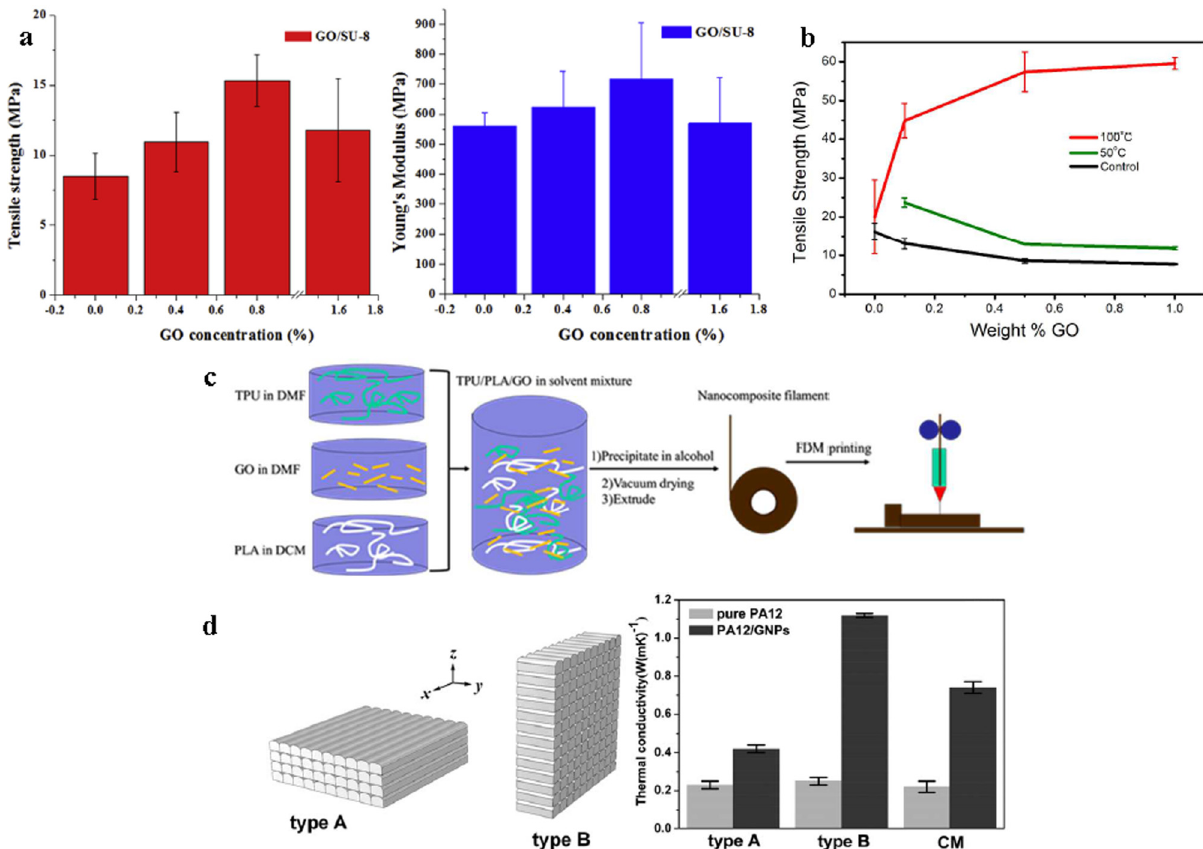
Figure 3: ( a ) Tensile strength and Young ’ s modulus curves of nanocomposites containing di ff erent concentrations of GO ( 0.4, 0.8, and 1.6 wt% ) . Reproduced with permission from ref. [ 54 ] , Copyright 2018 Elsevier. ( b ) Tensile strength as a function of GO loading